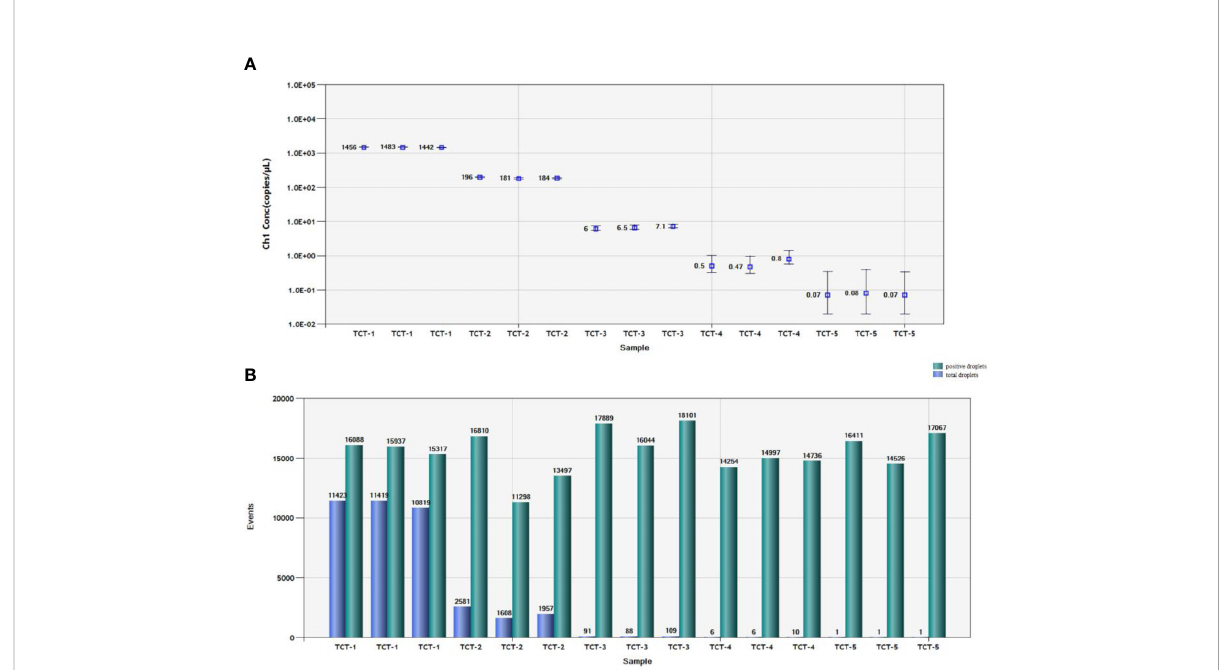
FIGURE 7 Statistical analysis by ddPCR. (A) Positive copy number analysis for detection of T. caries by copy number; TCT-1, DNA template of T. caries (2.4 pg/ m L); TCT-2, DNA template of T. caries (0.24 pg/ m L); TCT-3, DNA template of T. caries (24 fg/ m L); TCT-4, DNA template of T. caries (2.4 fg/ m L); TCT-5, DNA template of T. caries (0.24 fg/ m L). (B) . Number analysis of T. caries isolates; TCT-1, DNA template of T. caries (2.4 pg/ m L); TCT- 2, DNA template of T. caries (0.24 pg/ m L); TCT-3, DNA template of T. caries (24 fg/ m L); TCT-4, DNA template of T. caries (2.4 fg/ m L); TCT-5, DNA template of T. caries (0.24 fg/ m L). The green pillars are the number of positive droplets, and the blue pillars indicate the number of total droplets (positive +